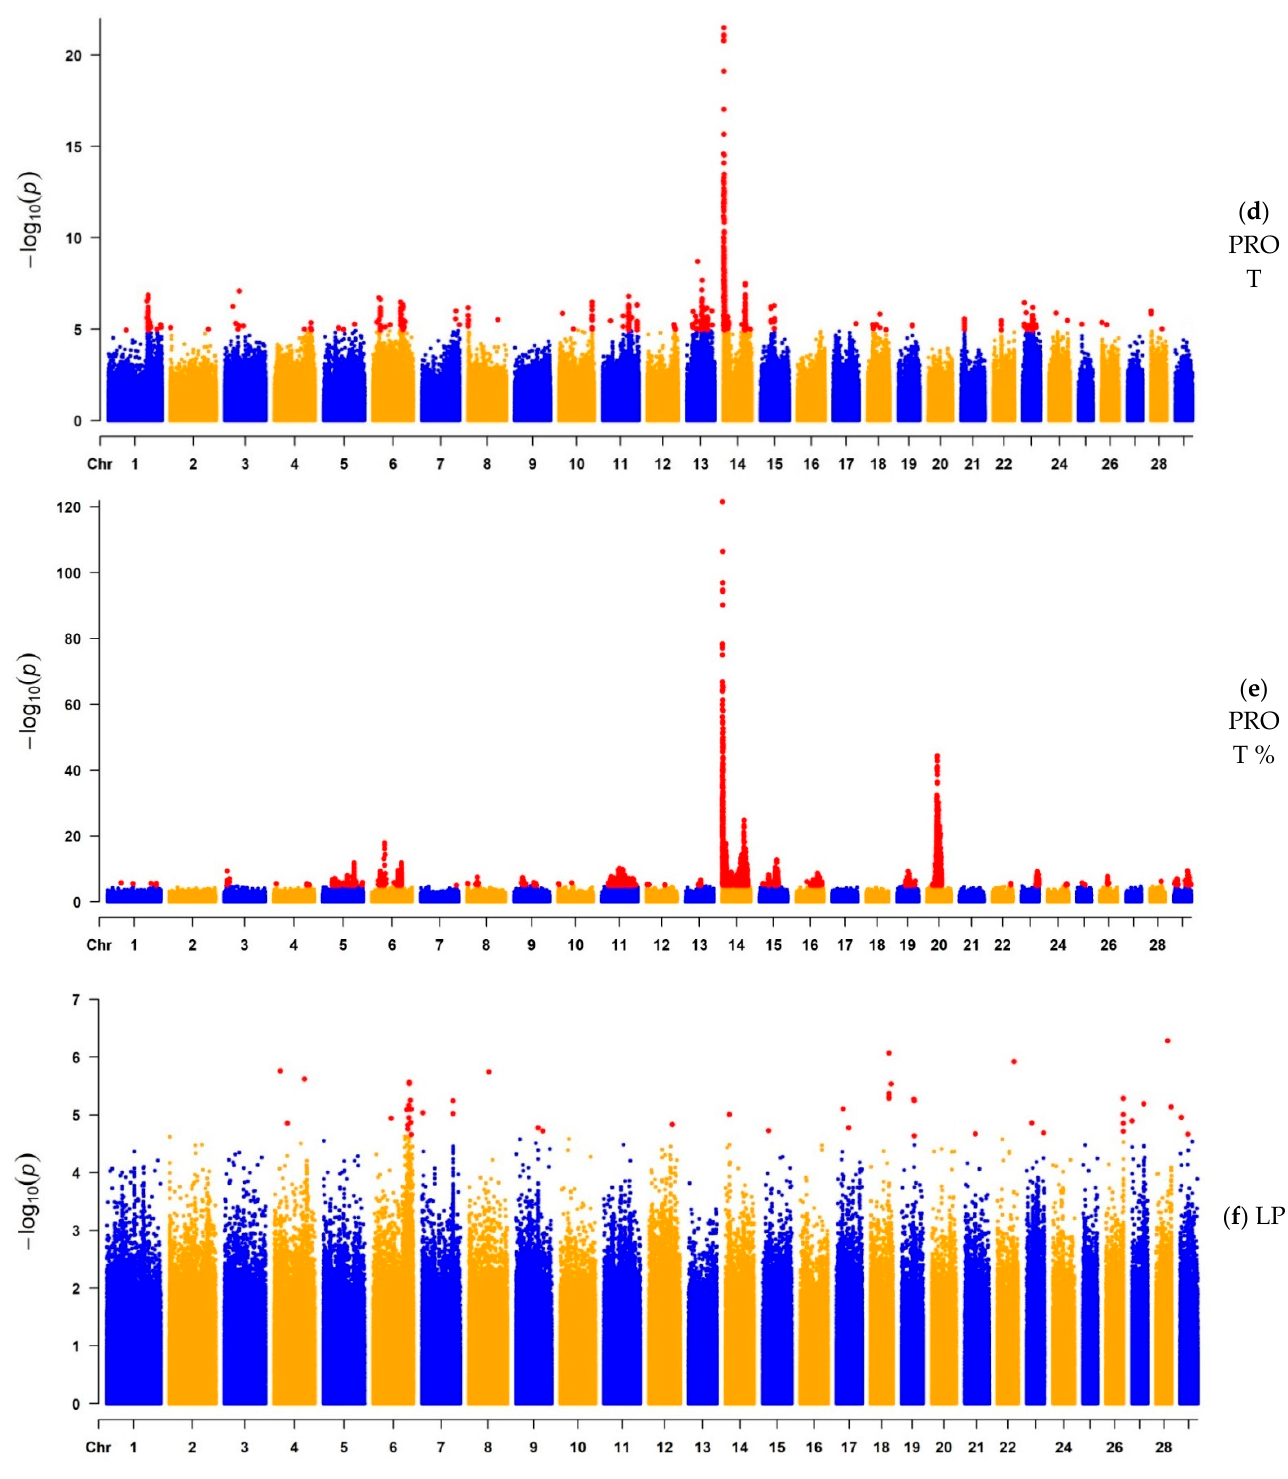
Figure 1. Manhattan plots of the GWAS results for milk yield (MILK), fat yield (FAT), fat percentage (FAT%), protein yield (PROT), protein percentage (PROT%), and lactation persistency (LP) based on imputed whole-genome sequence data. Statistically significant SNPs are represented by red dots.